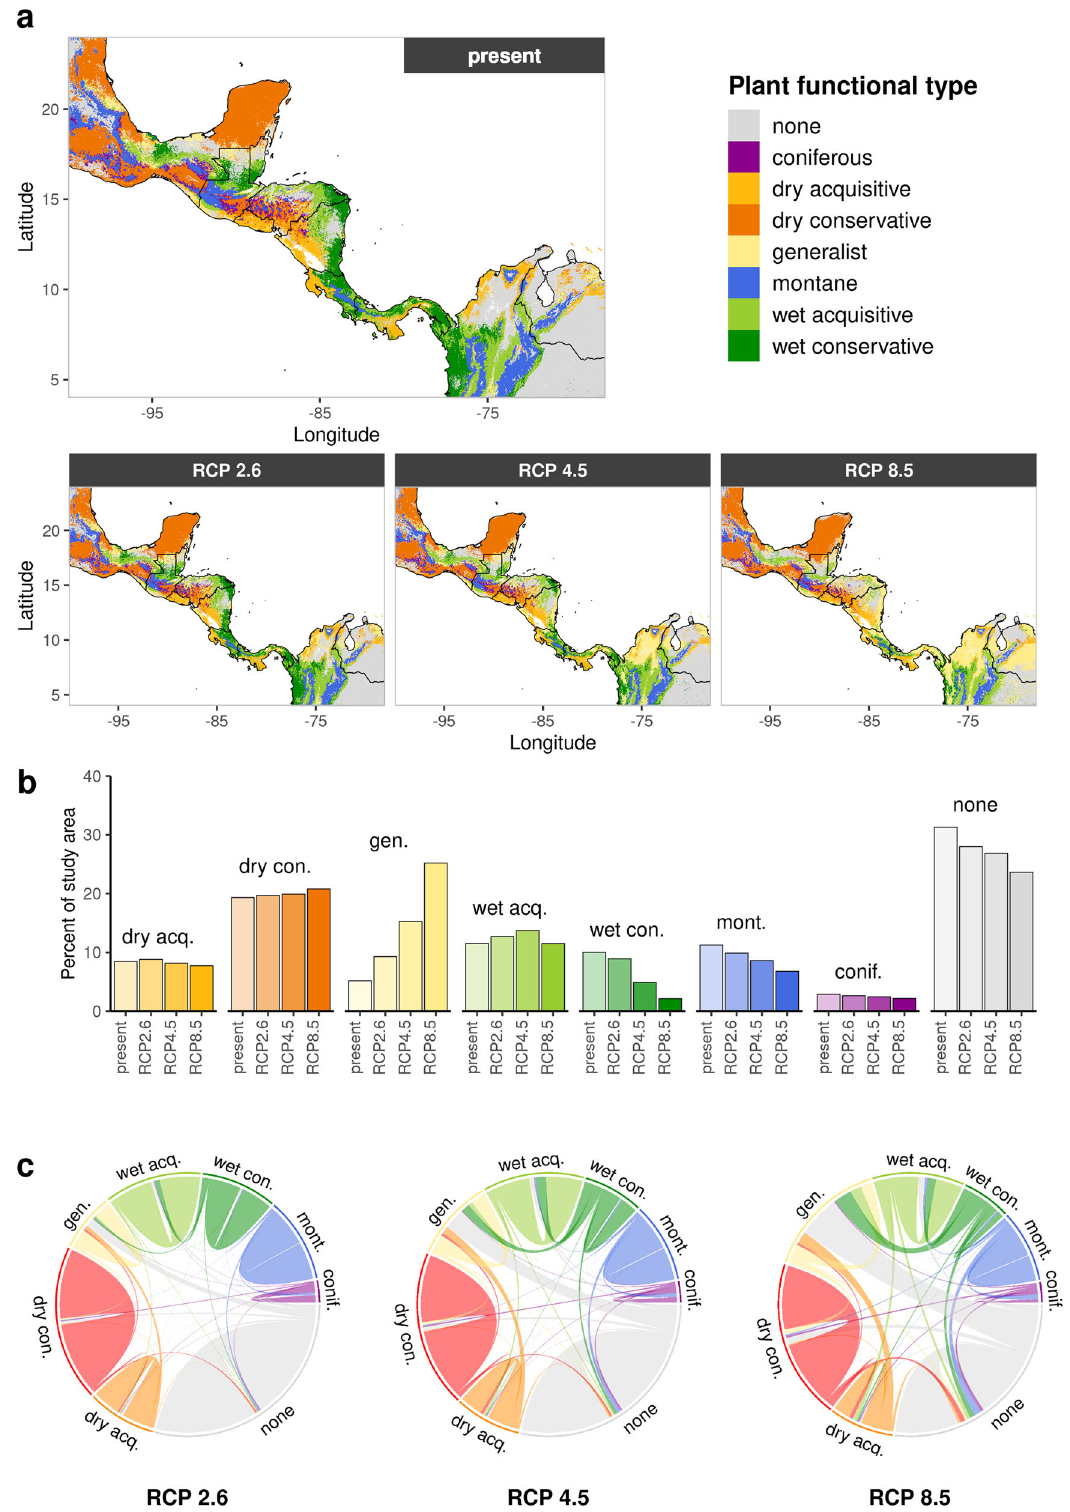
Fig. 1 Dominant PFTs. Model projections for the CCSM4 scenarios. a Maps showing the dominant PFT (type with the highest occurrence probability) for each grid cell. “ None ” refers to the case, where fewer than two species were predicted as present for every type (bS-SDM < 2). b Relative area covered by each dominant type (area statistics of a ). c Chord diagram illustrating fl ows between dominant types for RCP 8.5 compared to present. All ( a ), ( b ) and ( c ) share the colour code of the PFT